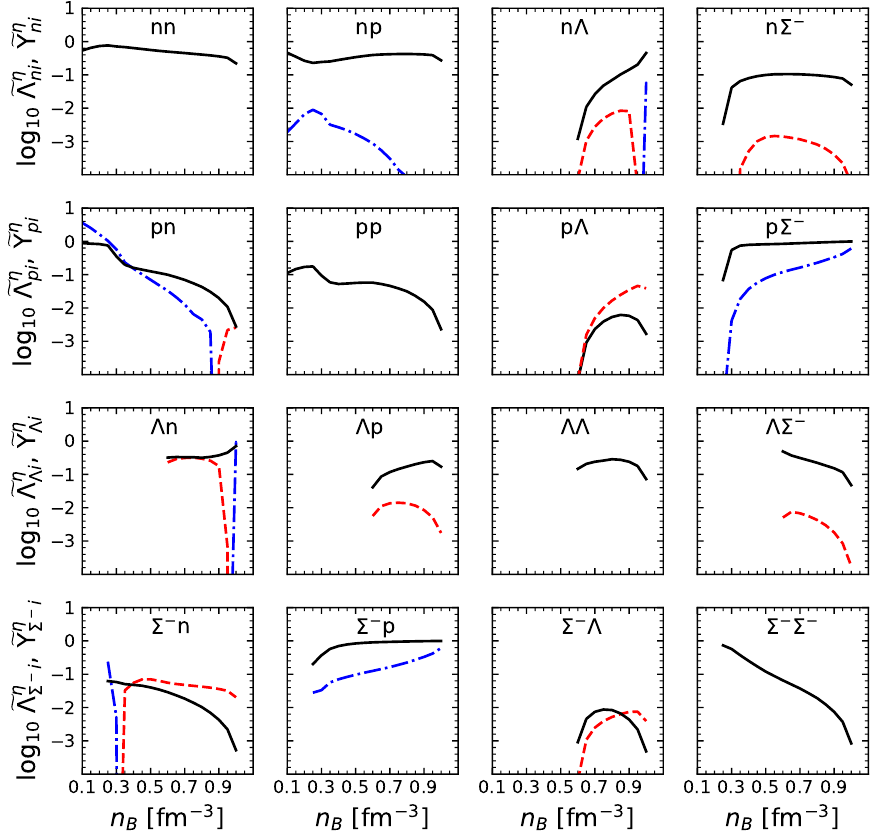
Figure 5. Normalized elements of the transport matrix for baryons for the shear viscosity case and NSC97e model. Solid lines in each row ( c = n , p , Λ , Σ − ) show relative contributions (cid:101) Υ η transport matrix elements. Other lines show the non-diagonal relative matrix elements (cid:101) Λ η red dashed lines correspond to positive values and the blue dash-dotted ones to negative values, respectively. Only strong forces are included, see text for